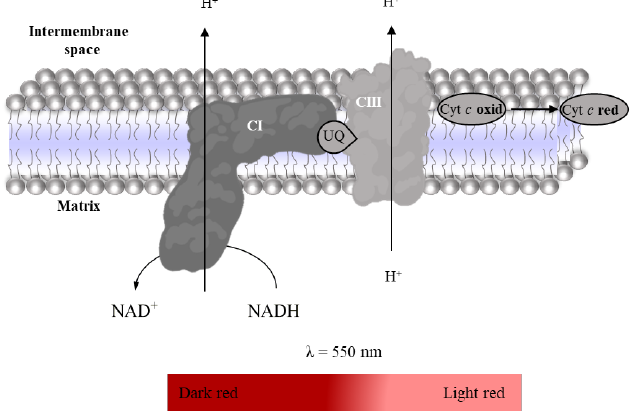
Figure 10. Reduction of oxidized Cyt c with oxidation of NADH to NAD+. Table 8. Conditions and flow setup for Super-complex I – III activity assay.